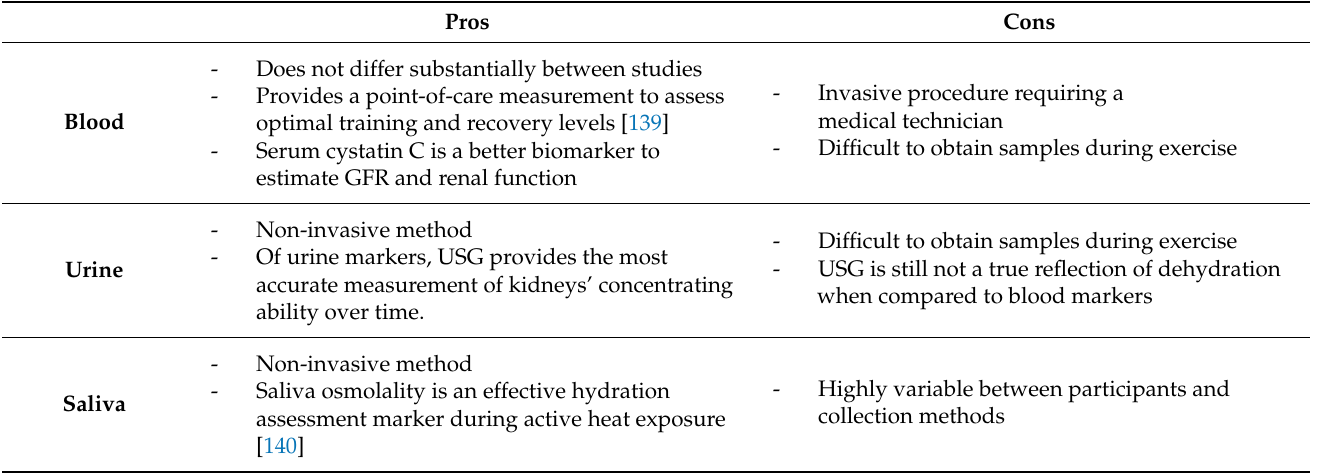
Table 5. Pros and cons of the blood, urine and salivary biomarkers in an exercise setting, and highlighting the ideal marker to measure hydration status within each body